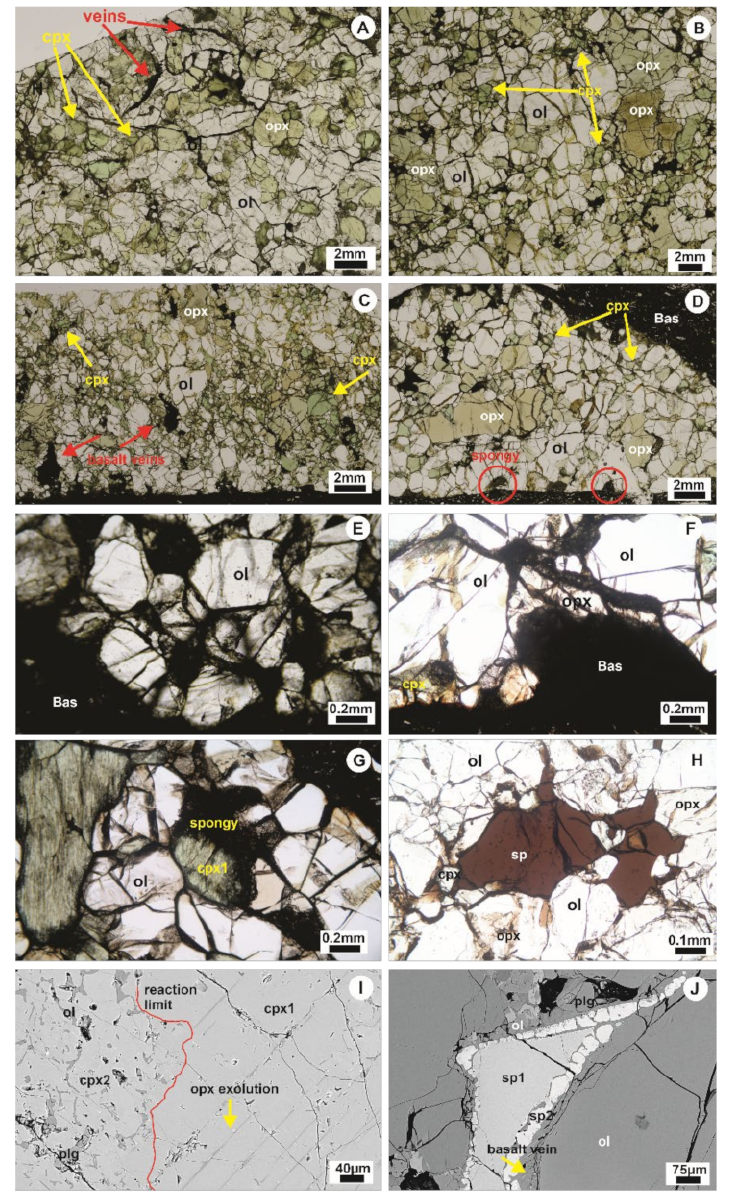
Figure 4. Petrographic features of Huanul xenoliths showing the main mineral phases and textures. ol = olivine, opx = orthopyroxene, cpx = clinopyroxene, sp = spinel, bas = host basalt. ( A ) granuloblas- tic texture, sample HU14; ( B ) porphyroclastic texture, sample HU34; ( C ) mosaic-porphyroclastic texture sample HU32; ( D ) porphyroclastic texture, sample HU17; ( E ) neoblasts in sample HU15; ( F ) orthopyroxene dissolution at the host basalt contact in sample HU23; ( G ) spongy texture around a primary clinopyroxene in sample HU12; ( H ) aggregate of primary spinels, sample HU32; ( I ) detail of the spongy-primary clinopyroxene contact, sample HU12; ( J ) reaction rims of spinel in contact with a basalt vein, sample